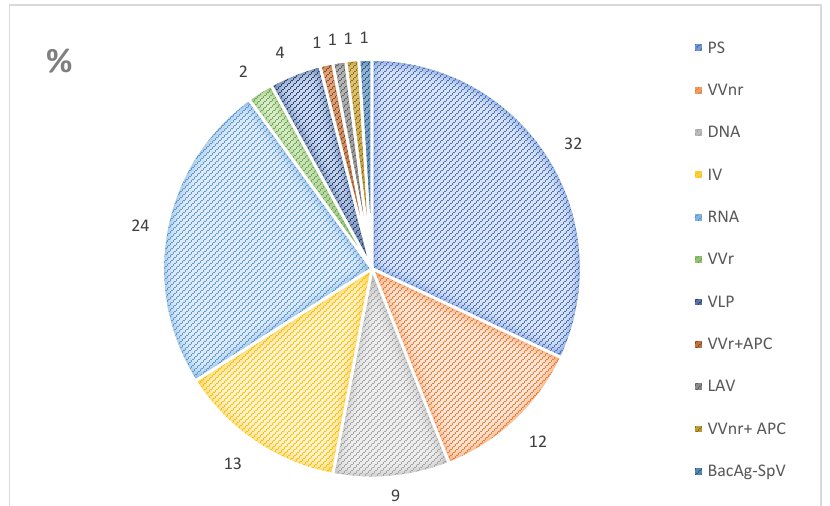
Figure 1. Proportion of vaccine platforms in clinical development [7]. Notes: PS, protein subunit; VVnr, viral vector non-replication; DNA, deoxyribonucleic acid; IV, inactivated virus; RNA, ribonu- cleic acid; VVr, viral vector replicating; VLP, virus-like particle; APC, antigen presentation cell; LAV, live attenuated virus; BacAg-SpV, bacterial antigen-spore expression